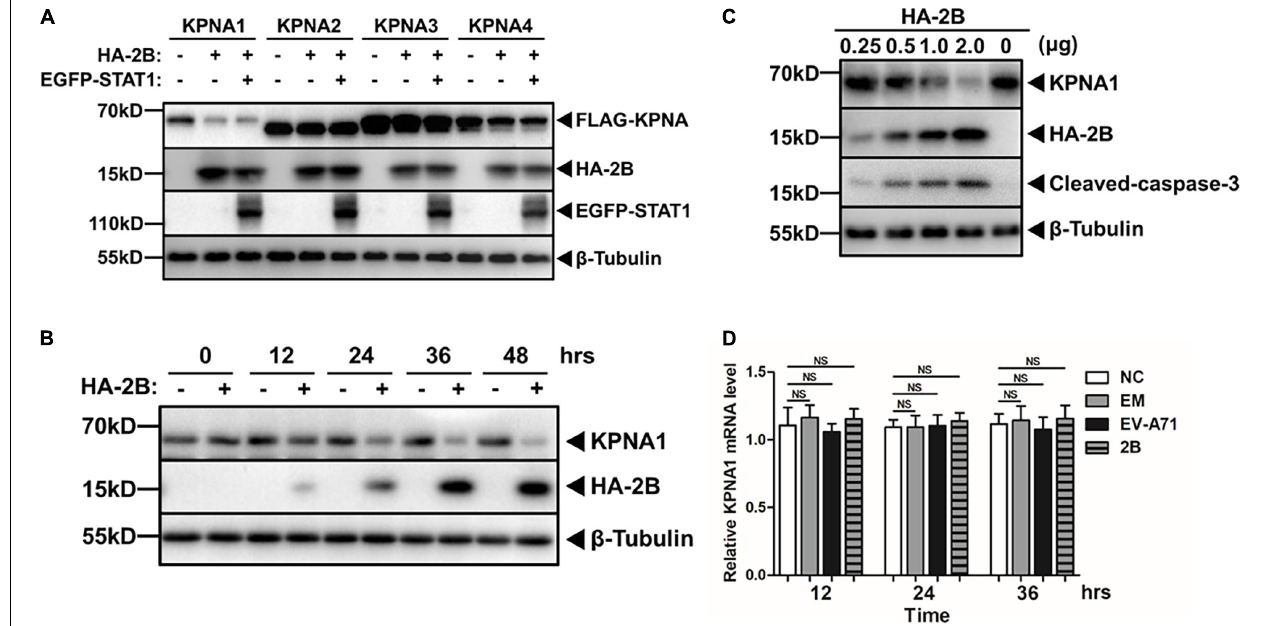
FIGURE 3 | Reduction of KPNA1 was specific among KPNA family members by 2B. (A) Viral 2B had minimal effect on KPNA2, KPNA3, and KPNA4 levels. HeLa cells were co-transfected with plasmids expressing HA-tagged 2B, EGFP-tagged STAT1 and FLAG-tagged KPNA1, FKPNA2, KPNA3, or KPNA4 (2.0 µ g each) for 36 h, followed by treatment of IFN- α (25 ng/ µ L) for another 2 h. Cell lysates were prepared for western blot analyses with antibodies for FLAG, HA, EGFP, or β -Tubulin. (B,C) Dynamics in the reduction of KPNA1 levels by 2B. HeLa cells were transfected with plasmids expressing HA-tagged 2B and cell lysates were prepared at various time points post transfection (B) . HeLa cells were transfected with varying amount of plasmids and cell lysates were prepared 36 h post transfection (C) . The cell lysates were analyzed by western blot analyses with antibodies for KPNA1, HA, or β -Tubulin. (D) Transcription of KPNA1 was not affected by 2B. HeLa cells were transfected with plasmids expressing HA-tagged 2B or infected with EV-A71 at an MOI of 1. Total RNA were prepared from the cells for real-time RT-PCR to measure mRNA transcripts of KPNA1 with specific primers. Values represent mean ± SD from triplicates of independent experiments. NS, no significance; NC, normal control; EM, empty vector